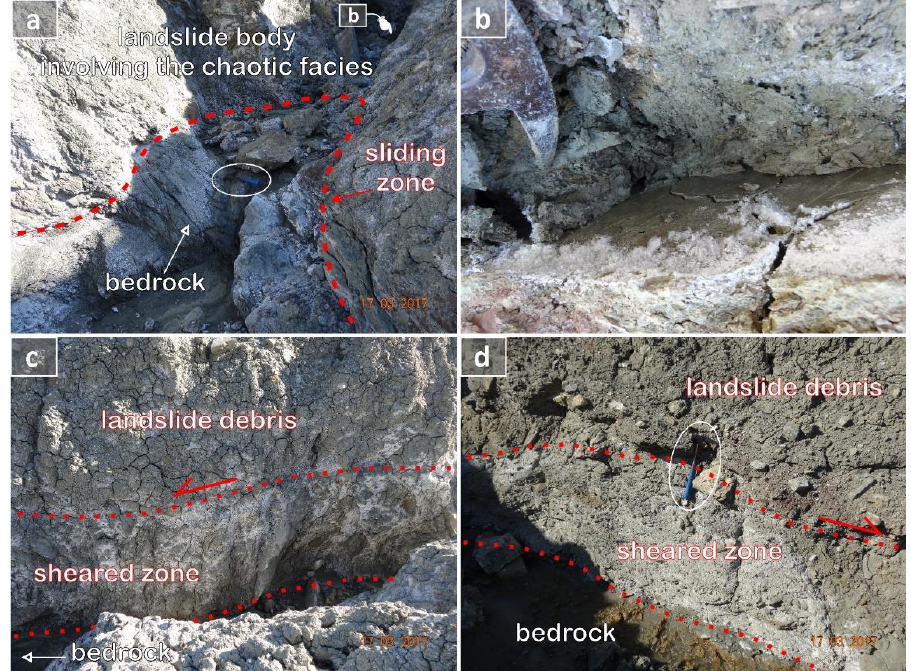
Figure 6. Observations on the internal structure of the landslide inside a deep gully generated by the deepening action of the runoff waters in the landslide body: ( a ) main sliding zone of the southern source areas; ( b ) detail of the sliding surface; sheared zones observed in the transport ( c ) and deposition ( d ) sectors of the landslide between the mobilized clayey material and the bedrock represented by the “schistose” facies of the Varicolored clay-shale Formation.